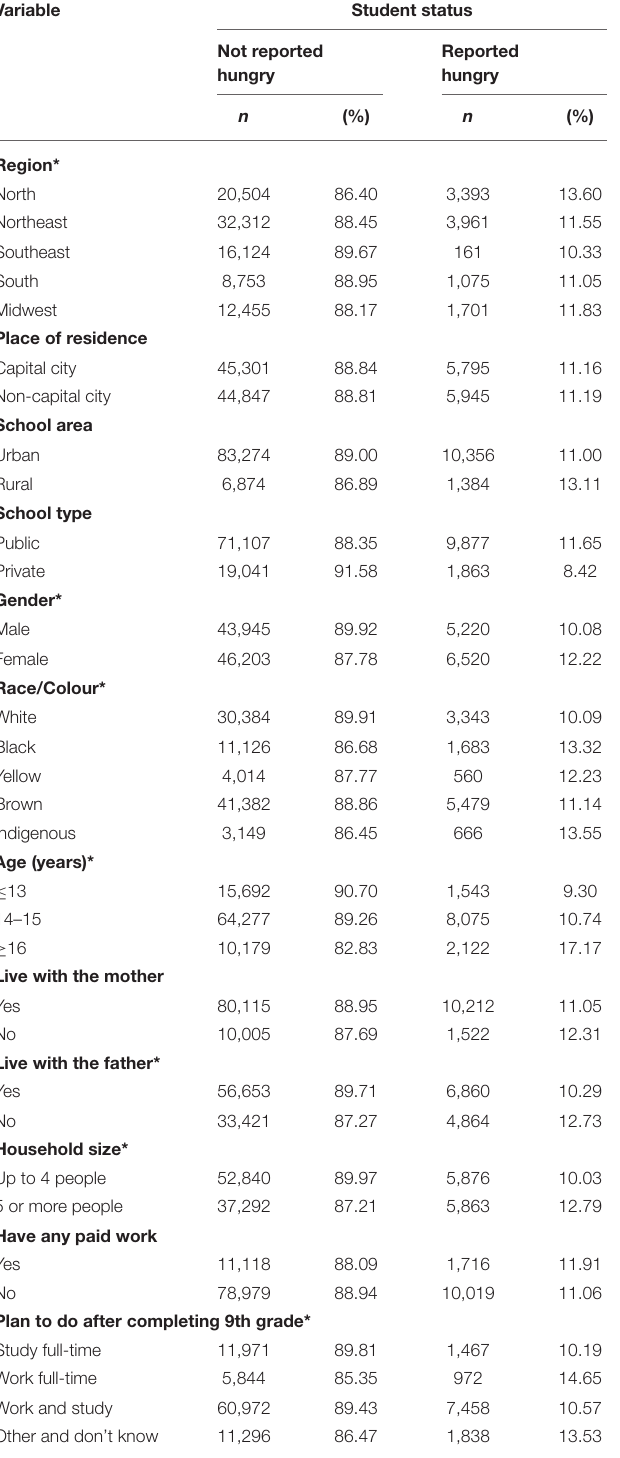
TABLE 2 | Results of Poisson regression model analysis of the association between self-perceived hunger and sociodemographic variables, Brazil, 2015. Crude